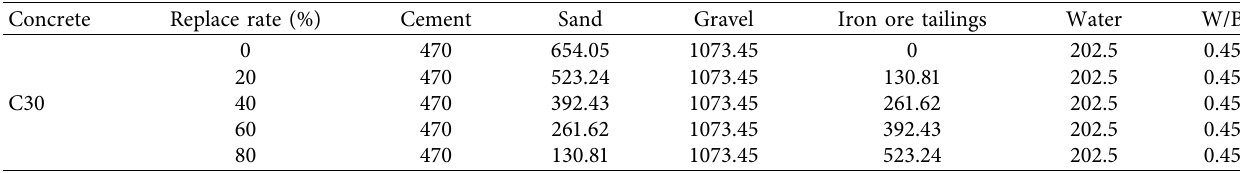
Table 3: Mix proportion of iron ore tailings concrete (kg · m − 3 ).